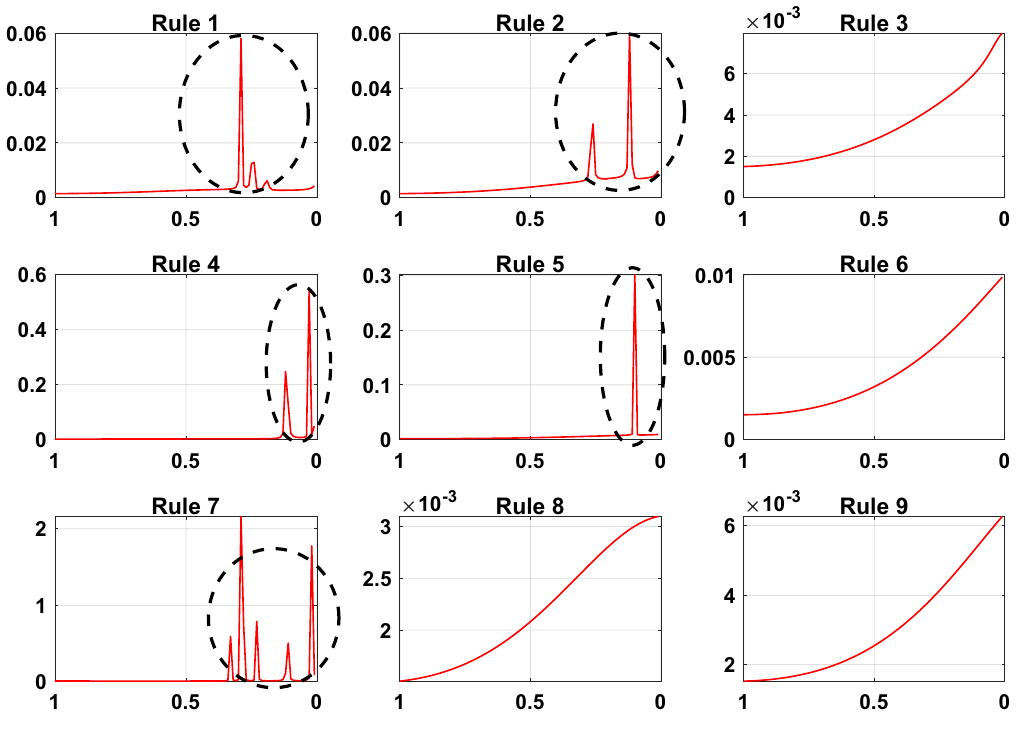
Figure 27. Sensitivity analysis of Sub-BRB3 of the DBRB-I(20) model (x-axis represents rule weights, y-axis represents